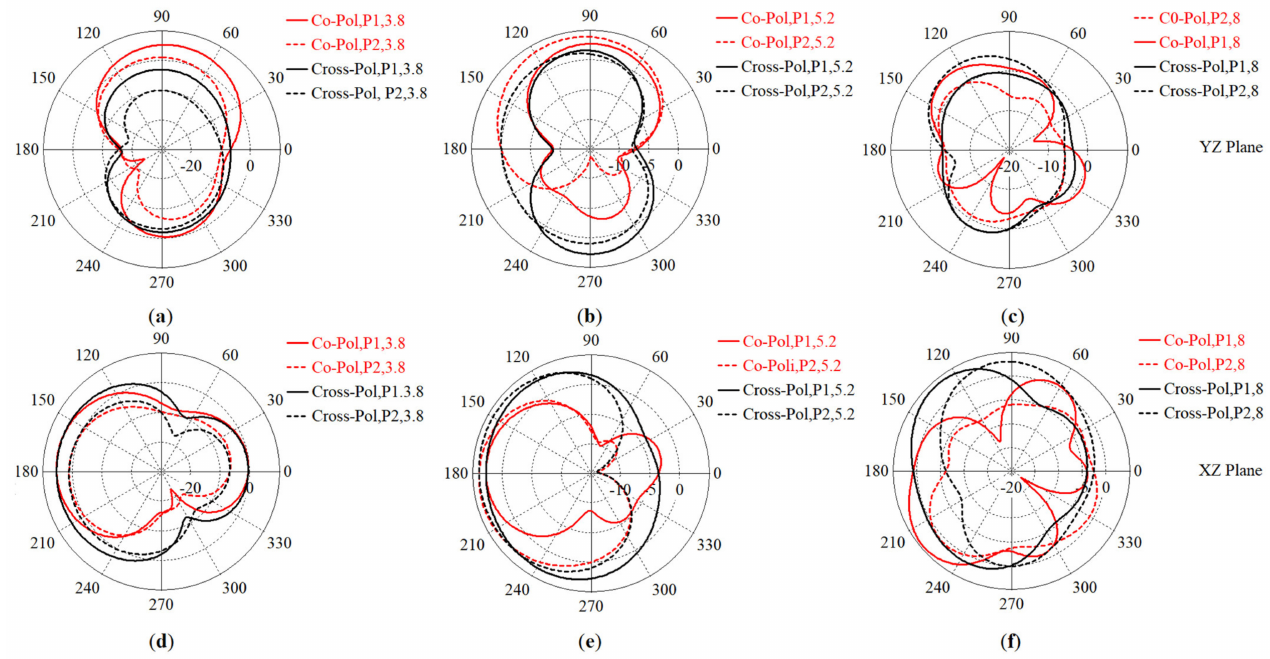
Figure 9. The simulated 2D co-polarization and cross-polarization radiation patterns of the proposed antenna without on the yz and xz planes: ( a ) and ( d ) 3.8 GHz, ( b ) and ( e ) 5.2 GHz, and ( c ) and ( f ) 8.0 GHz.